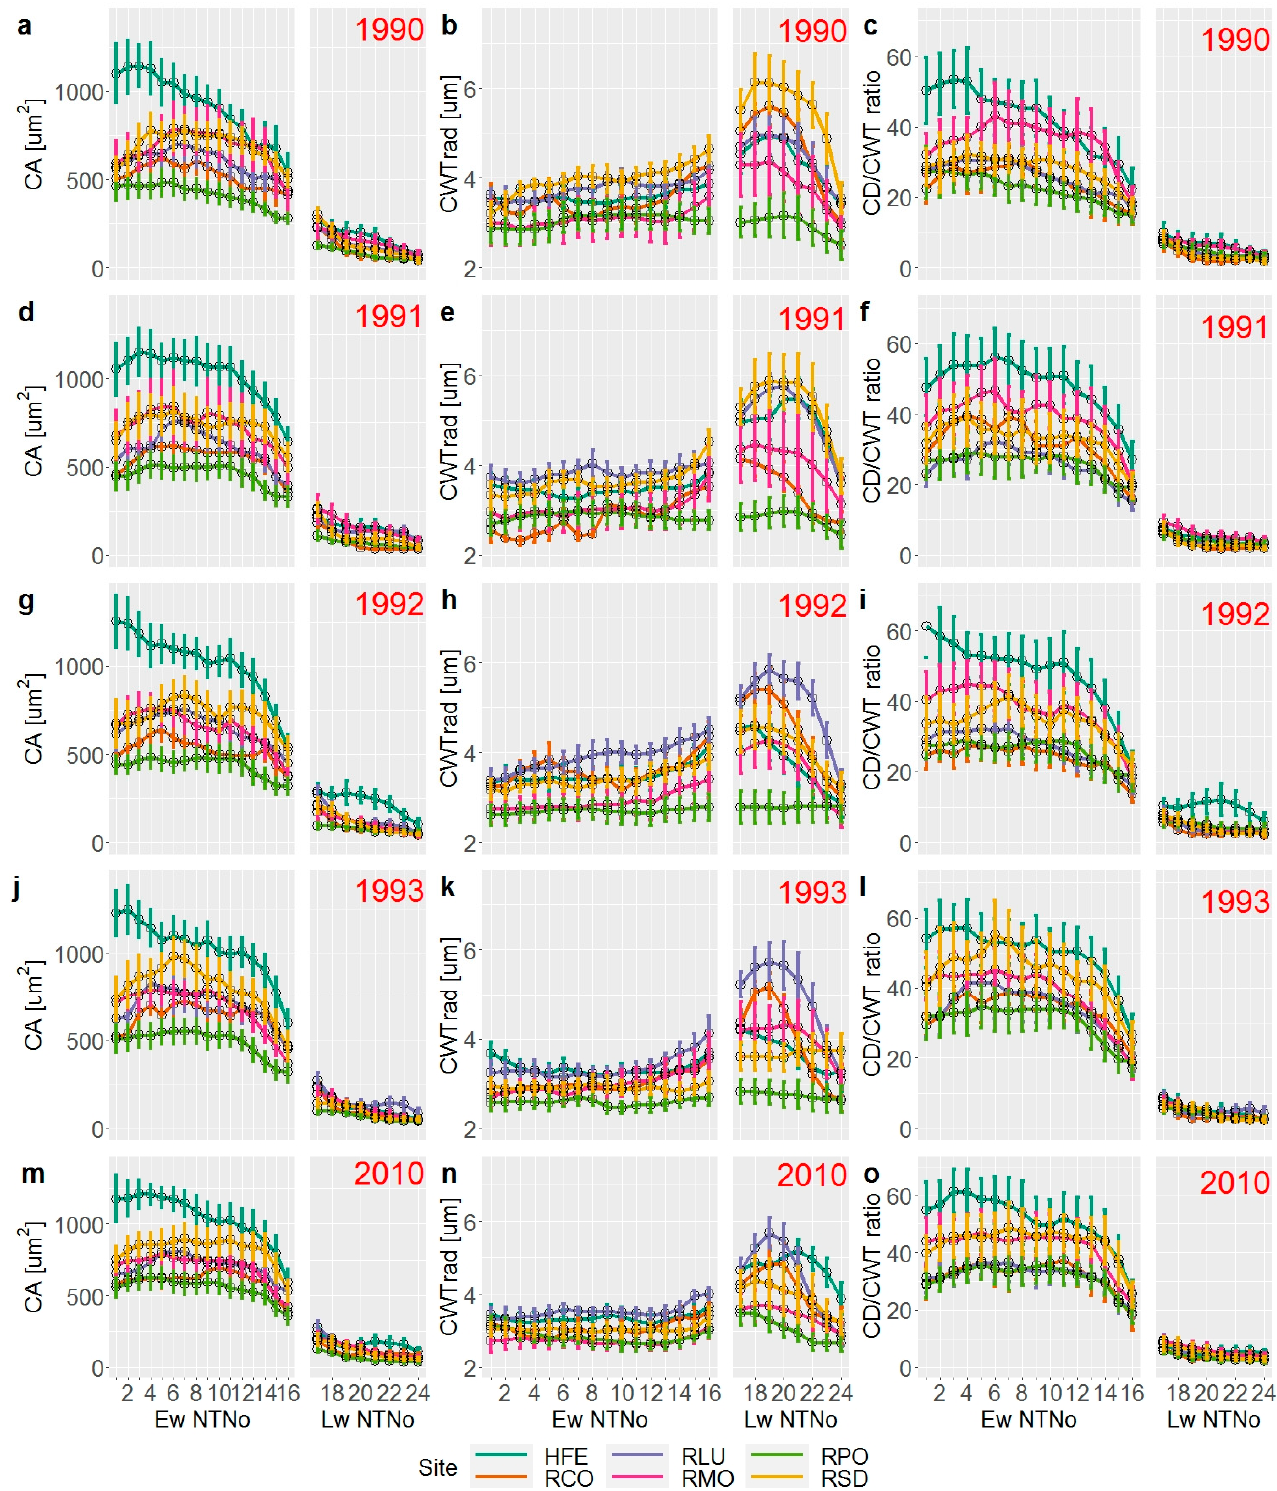
Figure 5. Average tracheidograms (tracheid parameter variations as functions of their normalized positions in radial files–NTNo.) for each studied year (1990–2010) at the studied sites of three measured wood anatomical features in earlywood (Ew) and latewood (Lw): CA cell area ( a , d , g , j , m ); CWTrad radial cell wall thickness ( b , e , h , k , n ); CD/CWT ratio of the cell diameter and radial cell wall thickness ( c , f , i , l , o ). Tracheidograms were obtained based on a normalized number of 24 cells (16 earlywood and 8 latewood). Lines with different colors indicate different sites, error bars indicate standard errors. Site abbreviations: Suhardul Mic (RCO), Tinovul Luci (RLU), B ă ile Tusnad (RMO), Poiana Stampei (RPO), Saru Dornei (RSD), Feny ő f ő (HFE).